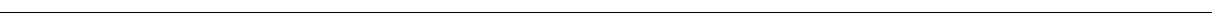
Fig. 2 Trypanosoma-infected mice show shorter circadian period. a Representative actograms of daily wheel-running activity of control and infected mice in constant darkness (DD). All running-wheel experiments involve seven days on LD12:12 followed by 10 days in DD to con fi rm that all animals have a normal circadian rhythm, after which animals are either infected or injected with vehicle in the dark. Horizontal black and white bars at the top of each actogram represent lights off and on for the initial acclimatization period, respectively. b Period of running-wheel activity of control ( n = 6) and infected ( n = 14) mice. c Representative actograms of daily wheel-running activity of control and infected mice in constant dark. Animals were treated with suramin (20 mg/kg) i. p. on day 21 post-infection (blue line). d Period of control ( n = 8) and infected ( n = 27) mice; *adjusted p < 0.05, ** p < 0.01, *** p < 0.001, FDR method Benjamini – Hochberg, for panels b and d . e Representative actograms of daily wheel-running activity of a control and three infected animals when challenged with consecutive dark to light period transitions. DD-1 fi rst period in DD started on day 60 post-infection, LD-1 when mice were transferred to LD, and DD-2 when transferred to a new DD period. f Circular phase plots of activity onset for the dark periods represented on the top panel. A circle represents a 24-h clock, and activity onset phases of individual mice were calculated as angles and plotted as colored symbols outside the circle. The direction of the vector indicates mean phase angle. Phase data are replotted on bottom panel as Circadian Time (CT). Shaded area represents subjective night; **adjusted p < 0.01, FDR method Benjamini – Hochberg. g Relative daytime activity in the light period after the dark period 1; ** p < 0.01, tested with Mann – Whitney test. Orange dotted line represents T. brucei infection start and blue dotted line the suramin